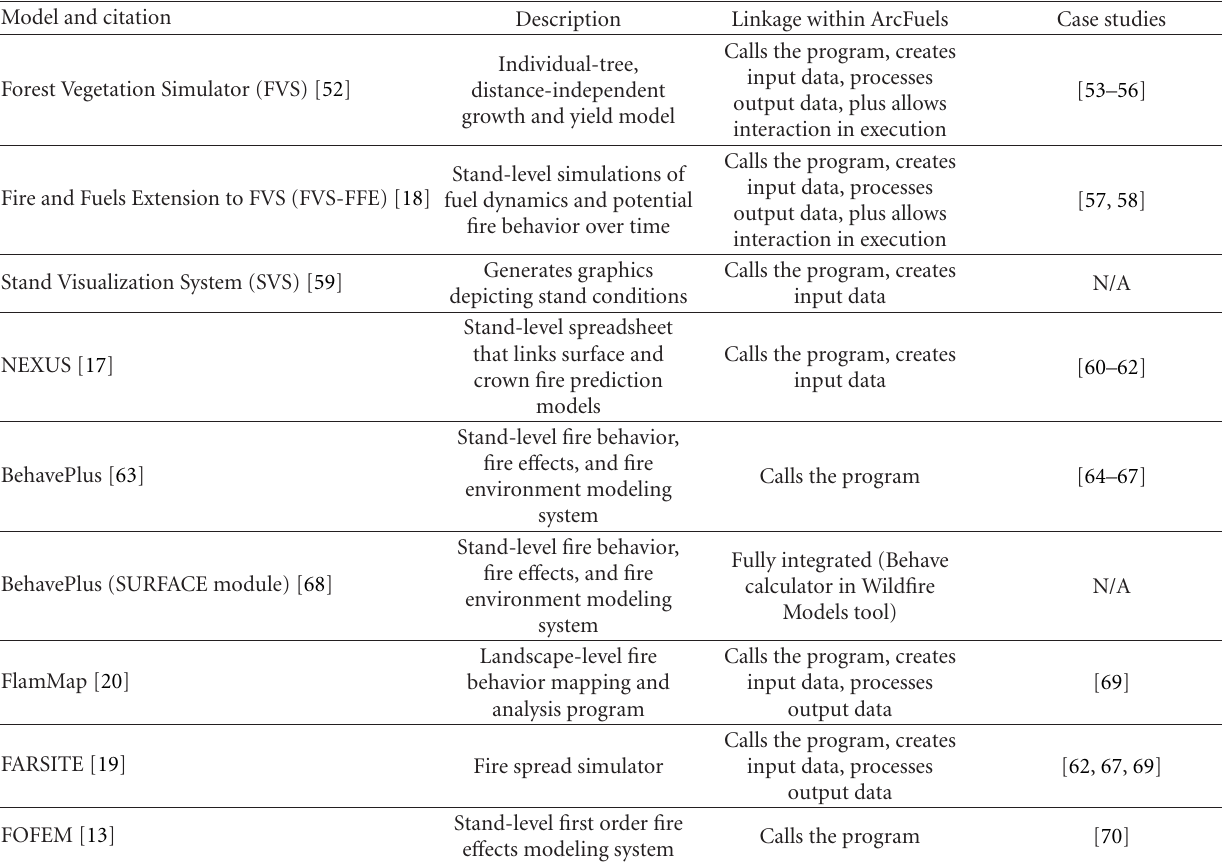
Table 1: Vegetation and fire behavior models used in conjunction with